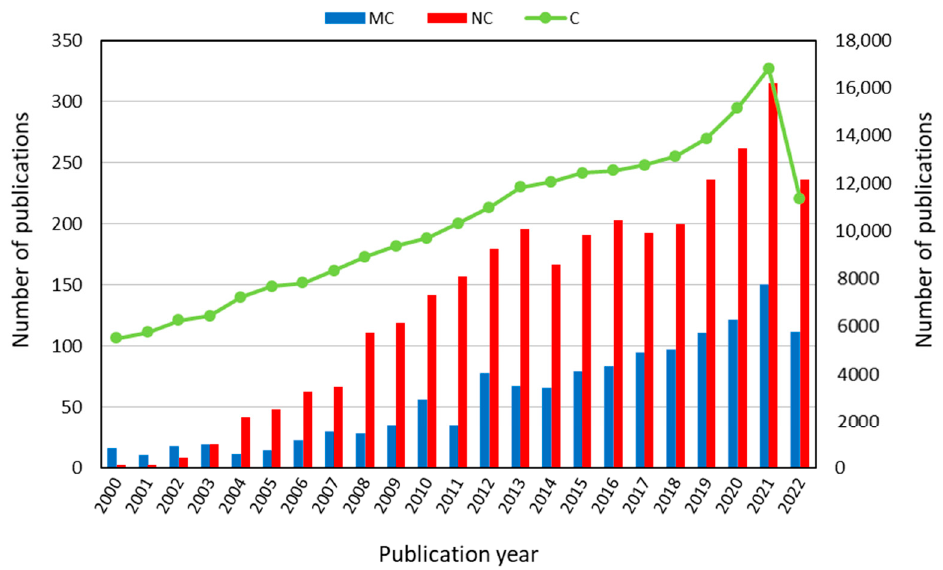
Figure 1. Increasing research interest in fish collagen (MC) and nano collagen (NC) compared with collagen (C), according to scientific papers analyzed by publication year in the last twenty years up to 2022 (from Scopus database: www.scopus.com, accessed on 15 September 2022).